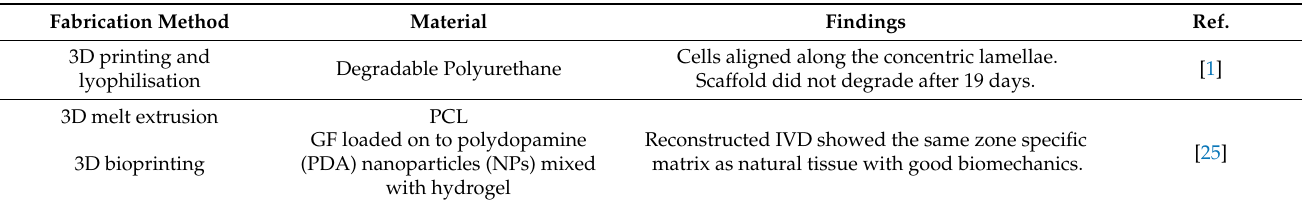
Table 1. Fabrication methods, materials and key findings of whole IVD tissue engineering studies that used additive manufacturing